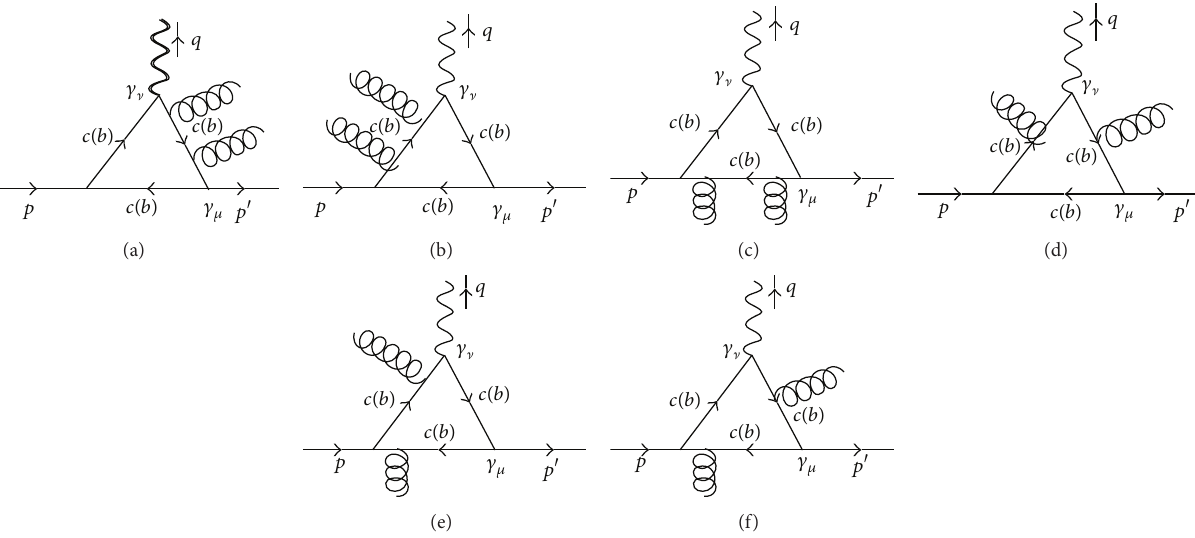
Figure 2: Two gluon condensate diagram as a radiative correction for the 𝜒 𝑐0 → 𝐽/𝜓𝛾 and 𝜒 𝑏0 → Υ𝛾